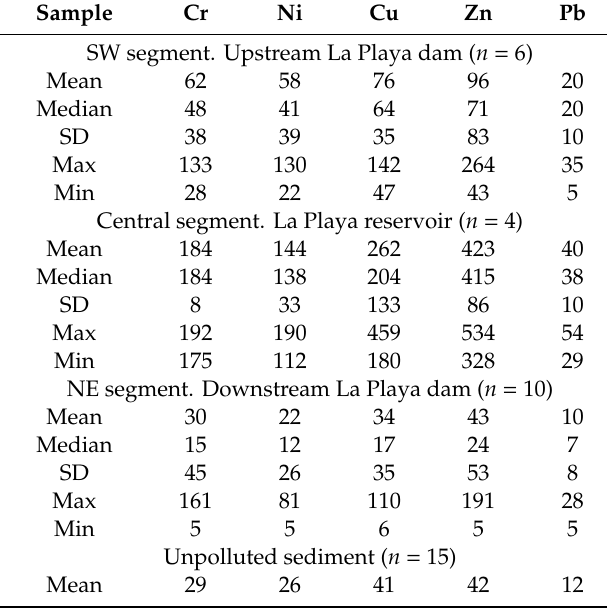
Table 2. Trace element sediment compositions determined by ICP-MS (for Cr, Ni, Cu and Pb) and XRF (for Zn) (in mg / kg). SD: Standard Deviation; Max: Maximum; Min: Minimum. Complete dataset is available in the Supplementary Materials (Table S2).